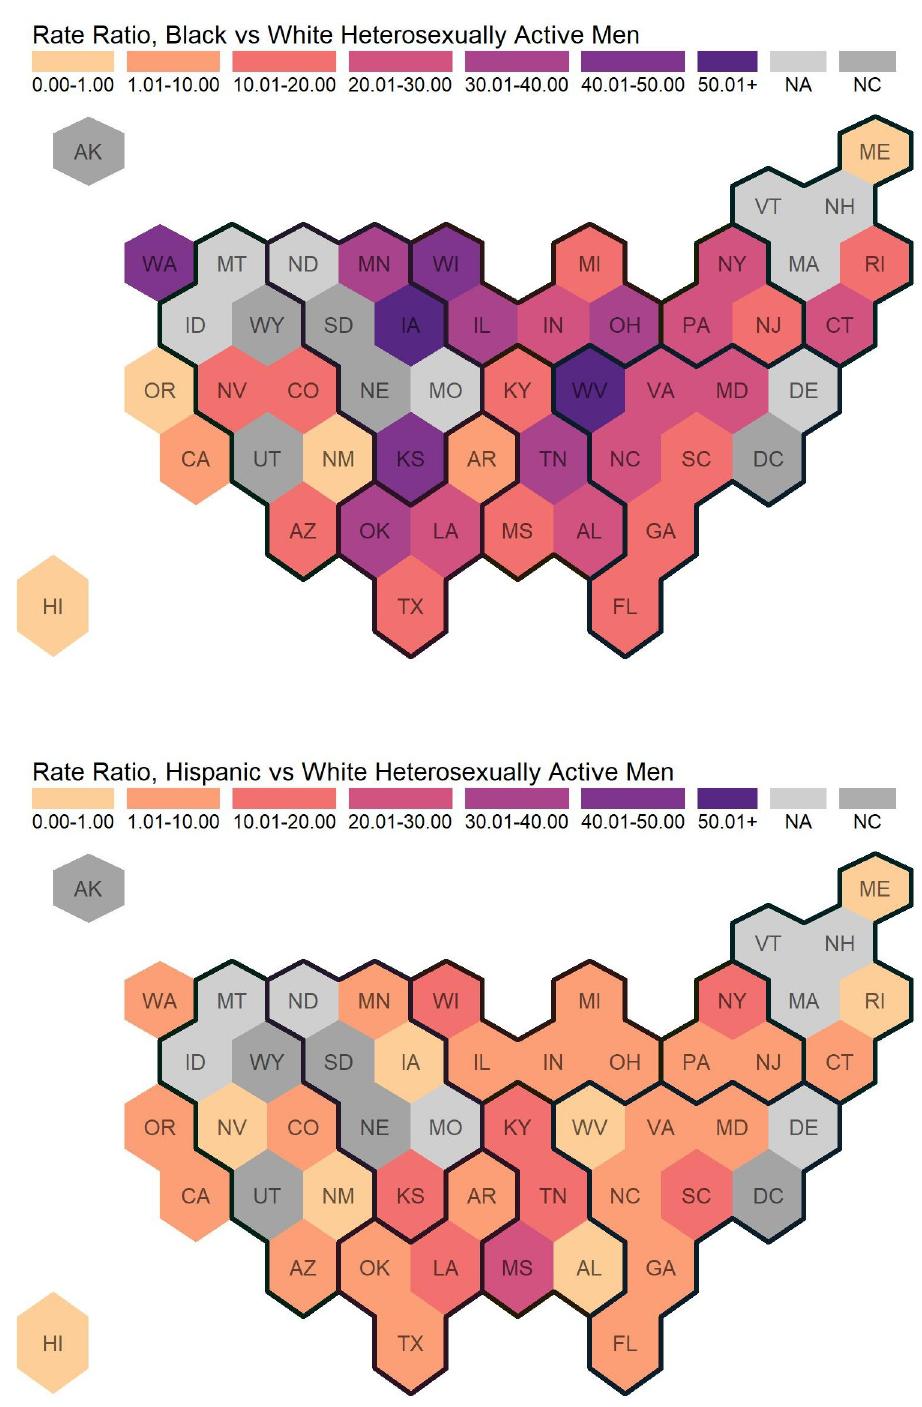
Fig 3. Rate ratios of newly diagnosed HIV cases among heterosexually active Men Ages 18+. Regions are indicated with the dark black lines. For most states in the lowest category with rate ratio between 0.00 and 1.00, there were no or very few new diagnoses among Black or Hispanic heterosexually active men. This commonly occurred in states with smaller populations. Eight states did not report stratified data (by sex, transmission category, and race/ethnicity), and are indicated with “not available” (NA). Six states do not have calculated rate ratios because there were 0 diagnoses among White heterosexually active men, and are indicated with “not calculated” (NC).